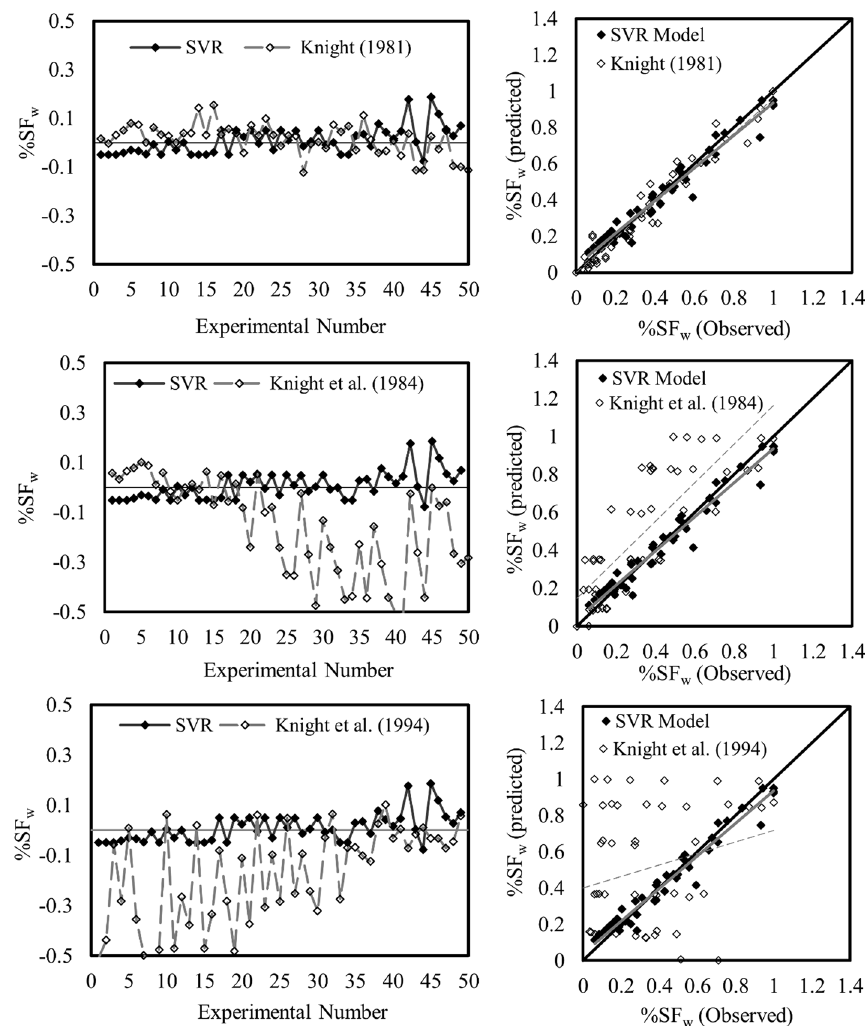
Fig. 4 Comparison between SVR model and other equations in predicting the %SF w for the entire